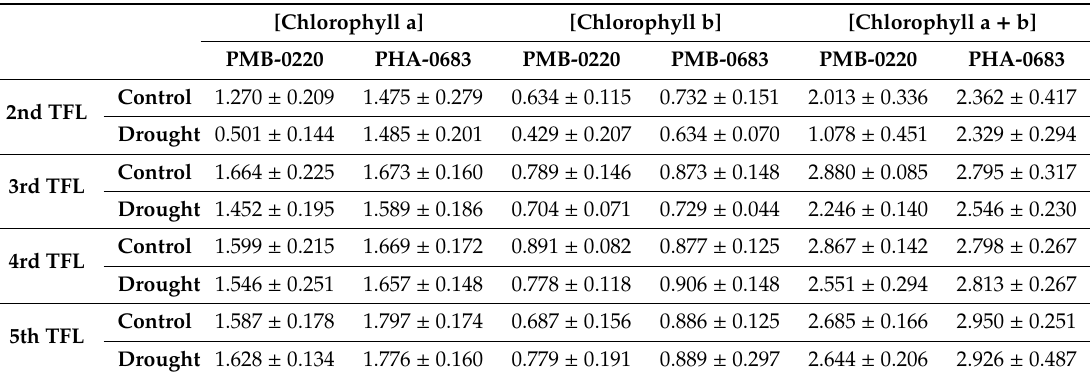
Figure 1. Physiological parameters of control and 10 days water deficit stressed plants of common bean PMB-0220 breeding line and PHA-0683 landrace, grown under symbiotic nitrogen fixation conditions for 28 days before the stress treatment. Relative water content of ( A ) soil and ( B ) leaf, and biomass of ( C ) roots and ( D ) shoots. Data are means of three independent experiments and asterisks indicate statistically significant differences (** p < 0.005) and (*** p < 0.0005). Table 1. Concentration of chlorophyll a, b and total chlorophyll in the 2nd, 3rd, 4th and 5th trifoliate leaves of P. vulgaris PMB-0220 and PHA-0683 subjected to well-watered and water deficit conditions for 10